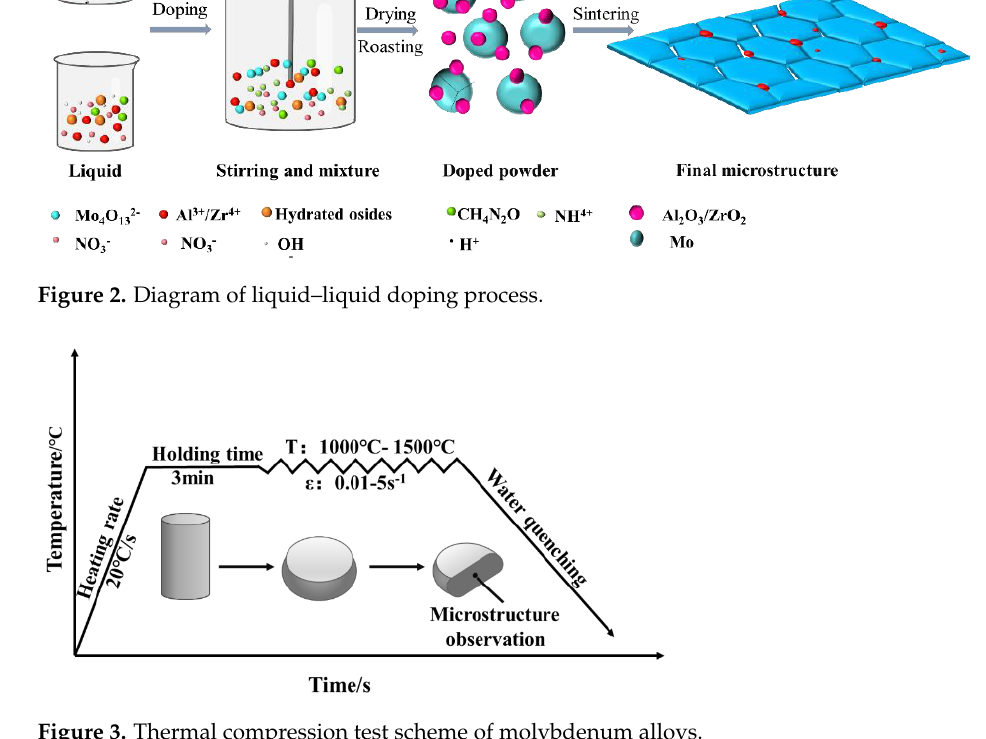
Figure 3. Thermal compression test scheme of molybdenum alloys.